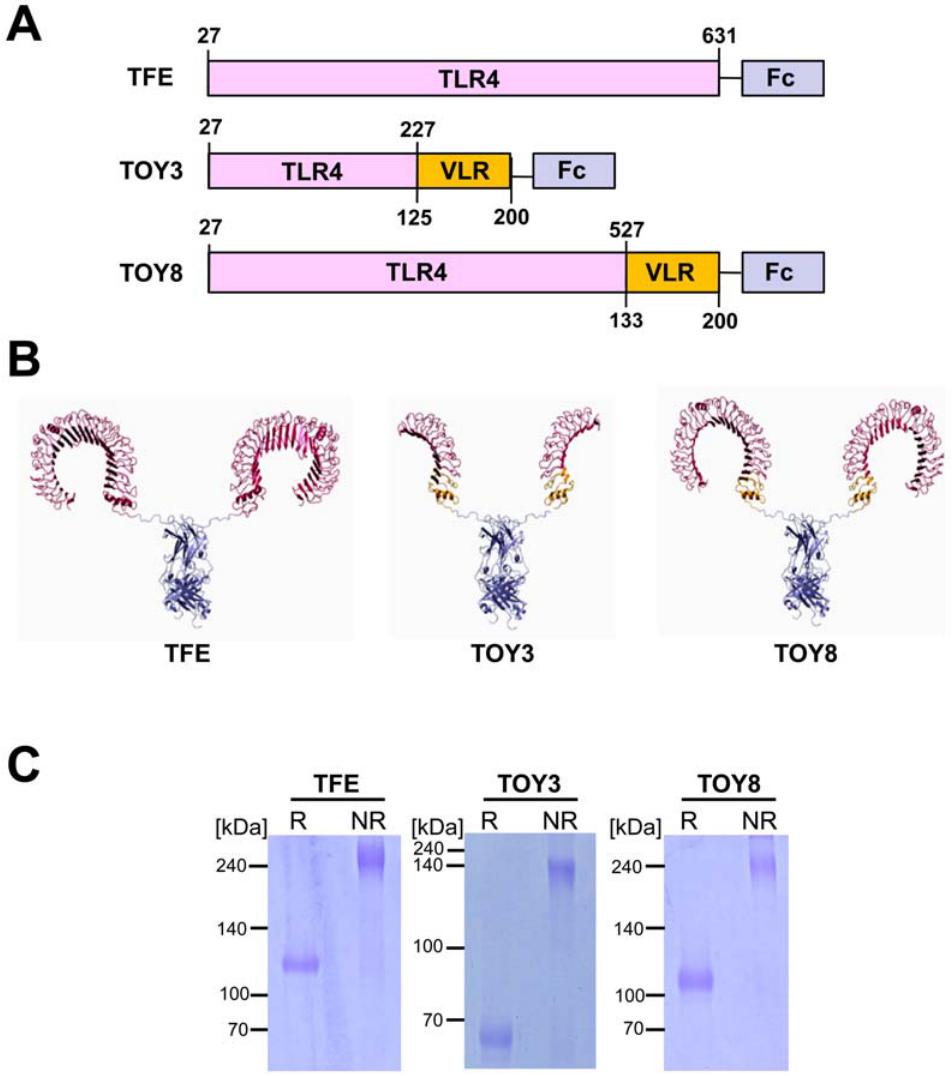
Figure 1. Structures of TFE and TOY constructs. ( A ) Schematic diagrams of the constructs showing the relative sizes of the human TLR4 ectodomain (TLR4), VLRB.61 fragment (VLR) of hagfish, and human IgG-Fc (Fc). Numbers indicate amino acids of the parental proteins. ( B ) Crystal structures based on computer modeling. The domains depicted are TLR4 (red), VLR (yellow), and Fc (blue). ( C ) Each 2 m g of reduced (R) and nonreduced (NR) proteins was separated by SDS-PAGE and stained with Coomassie blue. Molecular masses (kDa) are indicated at left.